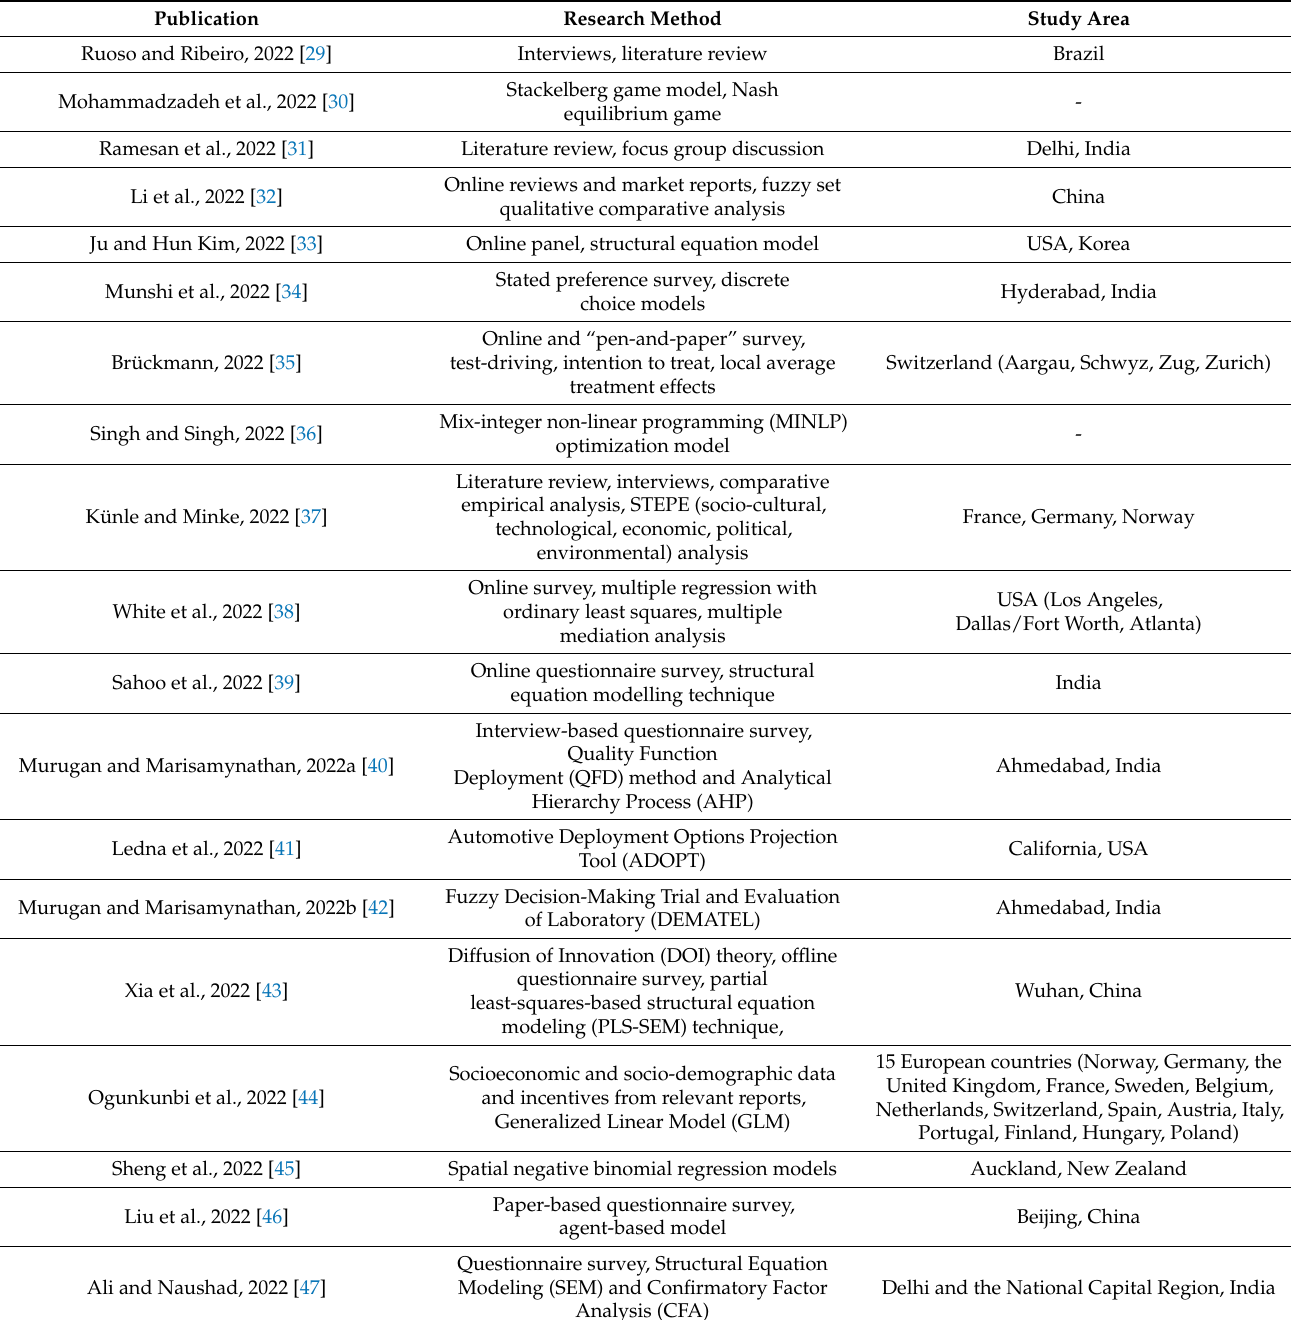
Table 1. Research methods in the existing